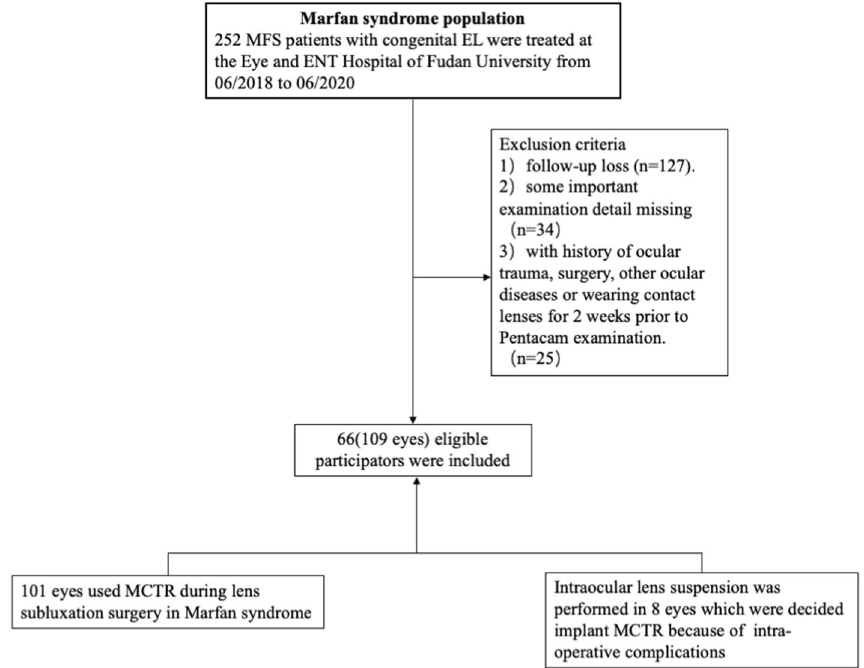
Figure 1. Flow chart illustrating the selection of patients in this